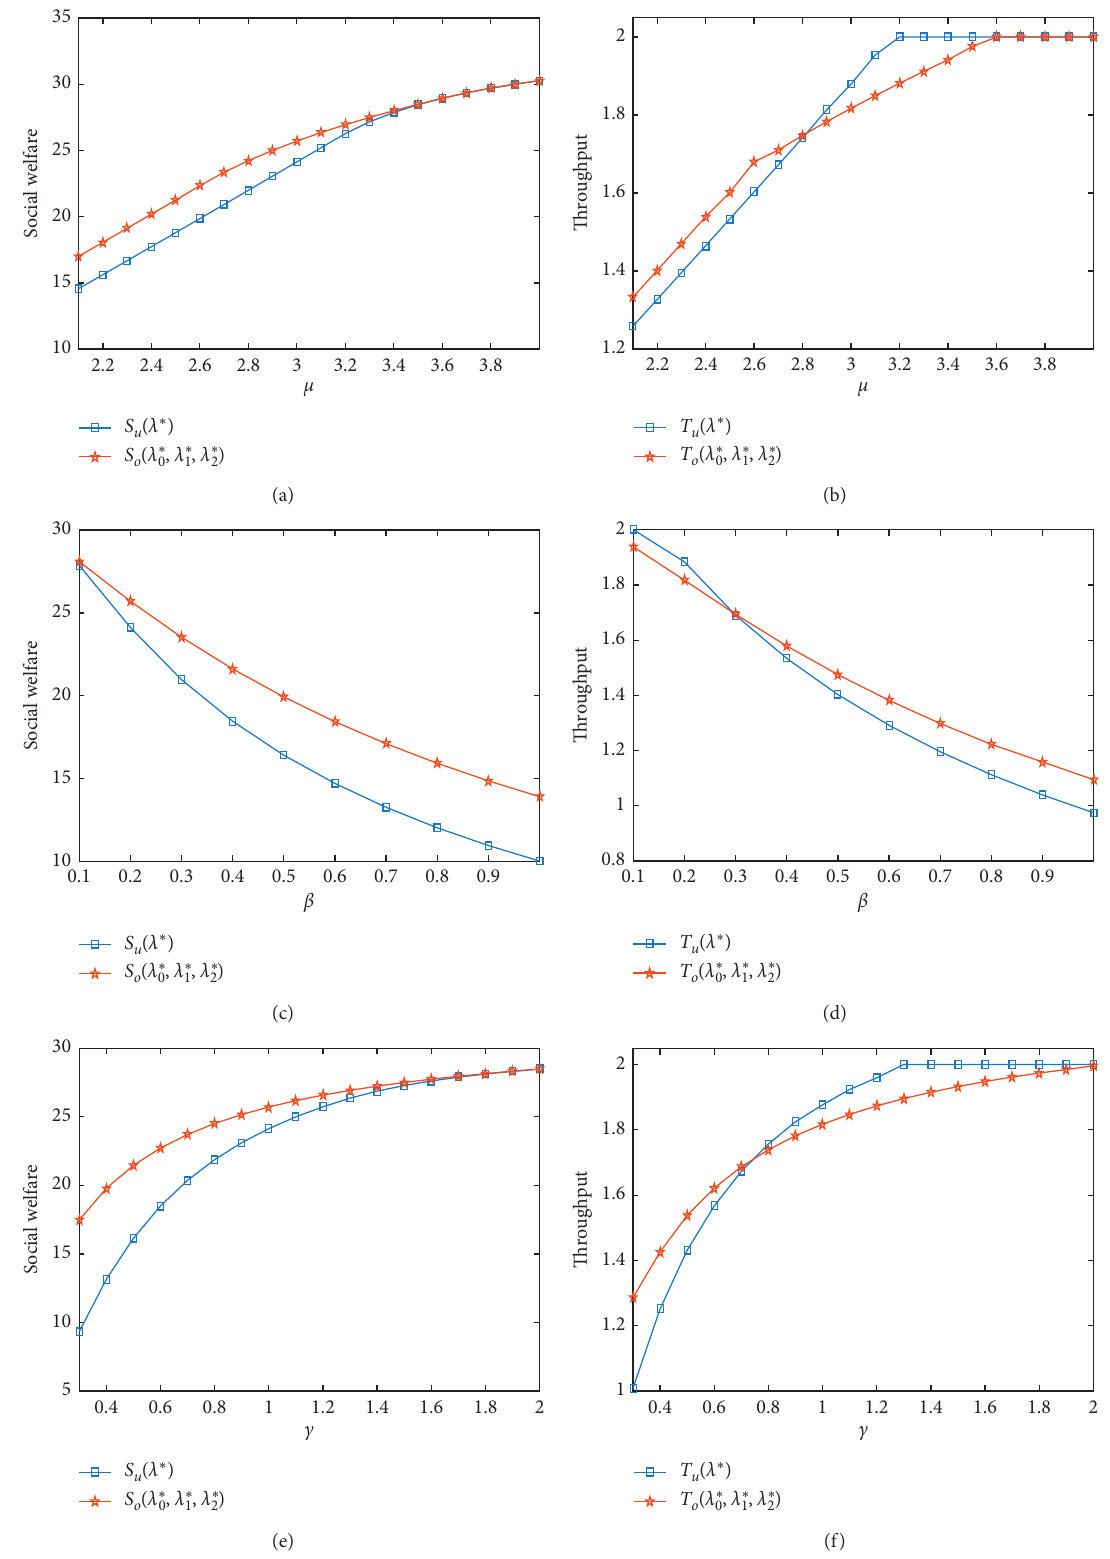
Figure 3: Social welfares S